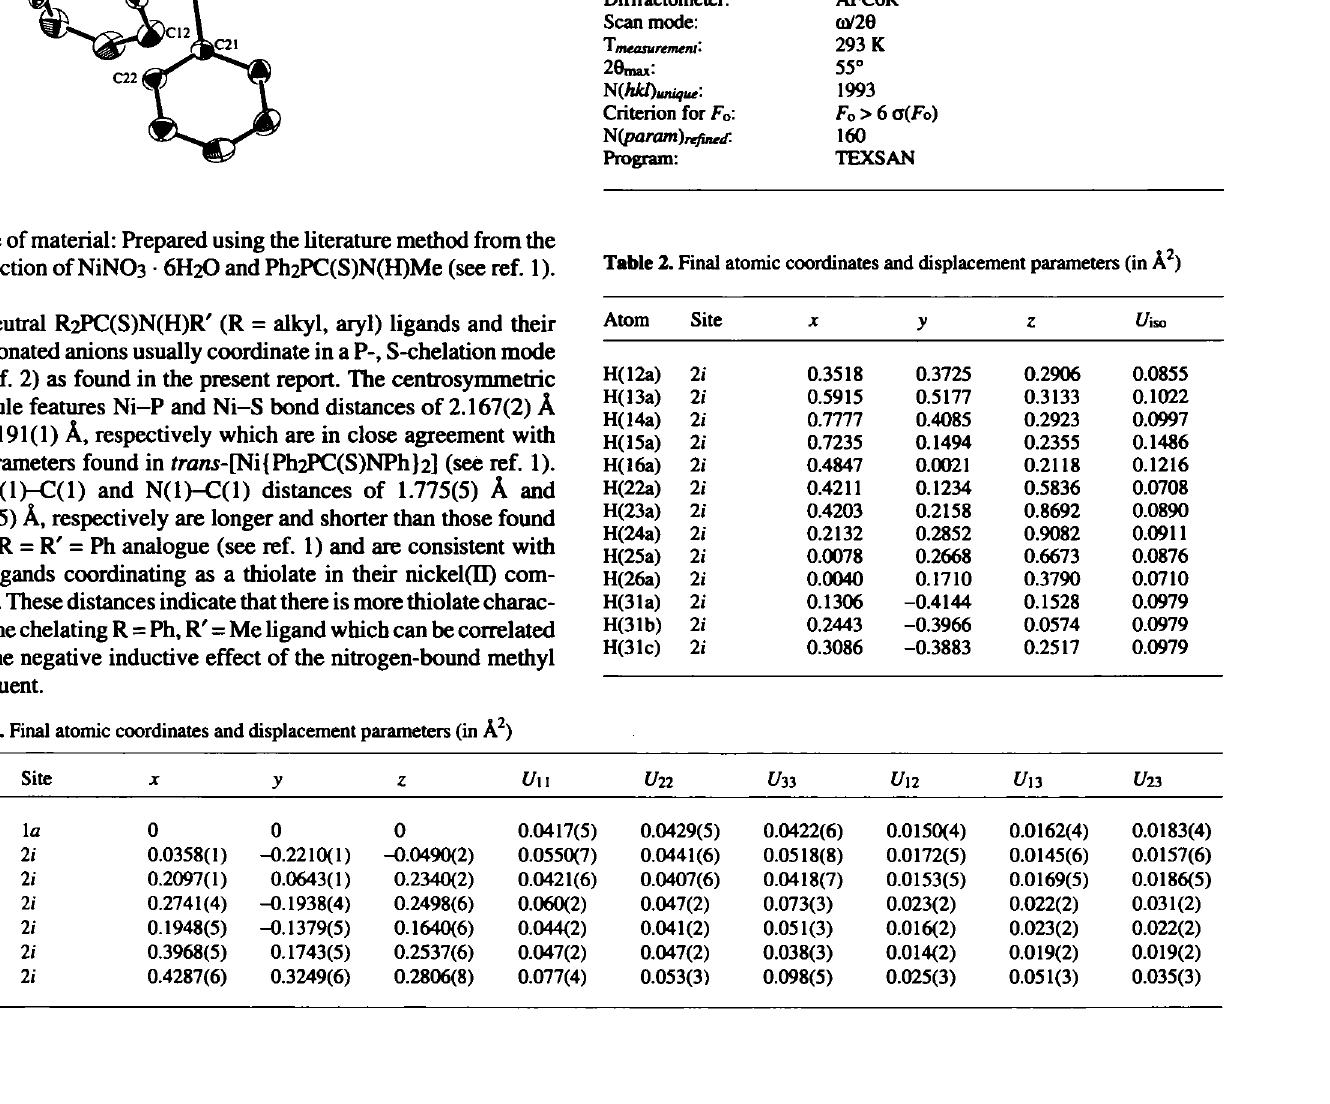
Table 1. Parameters used for the X-ray data collection Crystal: Wavelength: